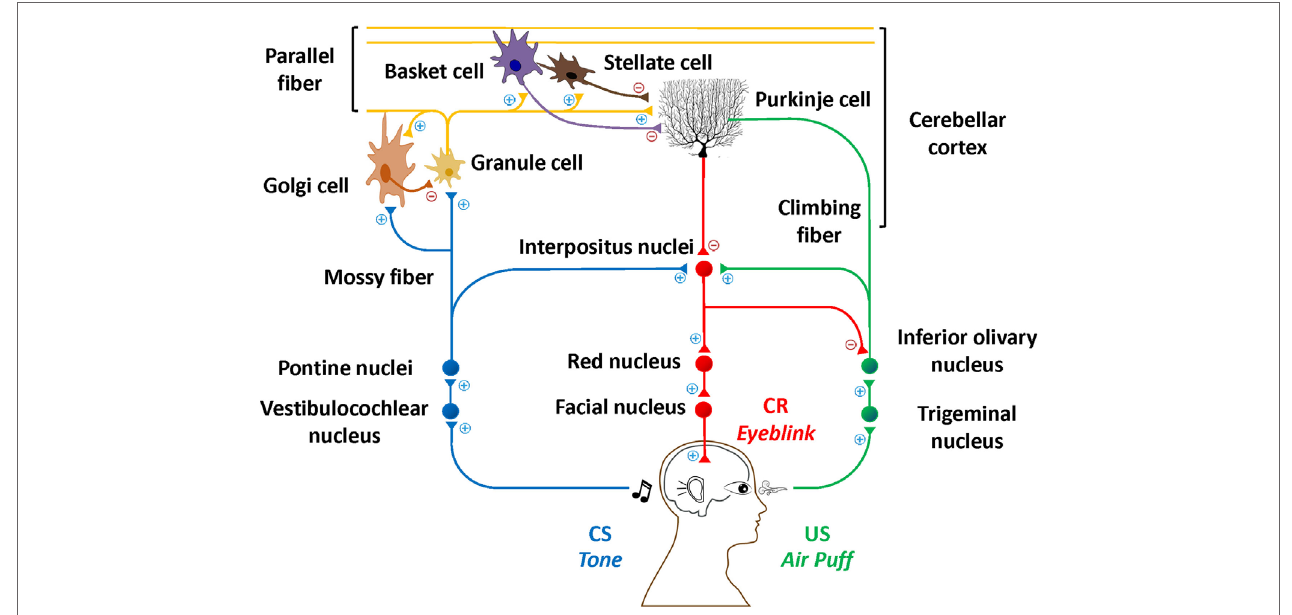
FiGURe 1 | essential neural circuitry of eyeblink conditioning . Blue lines indicate the conditioned stimulus pathway. Green lines indicate the unconditioned stimulus pathway. Red lines indicate the conditioned response pathway. Excitatory and inhibitory synapses are represented by + and − ,